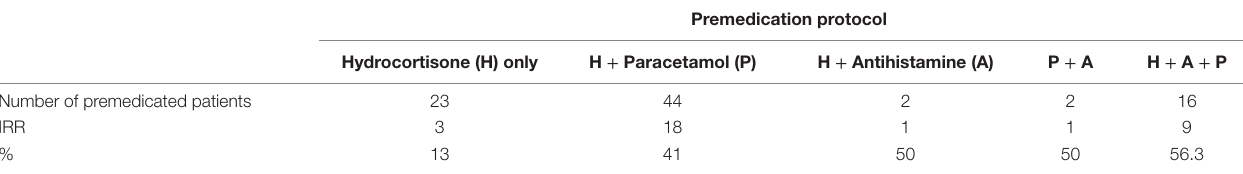
TaBle 5 | infusion-related reactions (irr) associated with amphotericin B lipid complex using different premedication regimens.